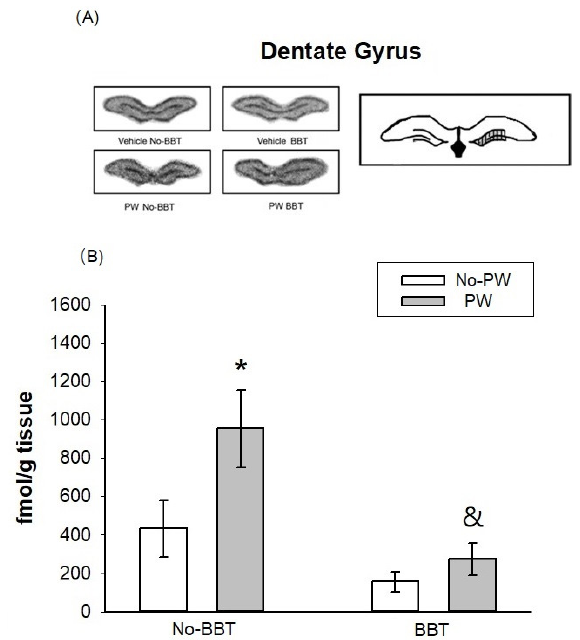
Figure 3. Representative photos of autoradiographic slides from the [3H]Flunitrazepam binding observed in the DG of the hippocampus (A), Effect of progesterone withdrawal (PW) on [3H]Flunitrazepam binding in the dentate gyrus of Wistar Kyoto rats (( B ), n = 4–6 per group). No-BBT = not tested in the burying behavior test; BBT = tested in the burying behavior test. Each bar represents the mean value ± standard error of the mean. * p < 0.05 vs. No-PW; & p < 0.05 vs. No-BBT. Figure 4A shows representative images of autoradiographic slides from the [3H]Flunitrazepam binding observed in amygdala nuclei. No change was observed in the basolateral nucleus (Figure 4B) due to BBT exposure or the PW. Two-way ANOVA values were obtained for treatment (F1,14 = 1.358, ns), behavioral test exposure (F1,14 = 3.122, ns), and interaction (F1,14 = 0.386, ns).